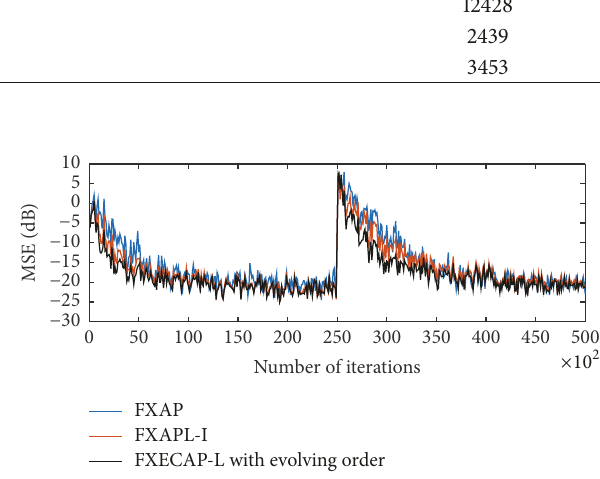
Figure8: MSEvaluesof thetestedAP algorithmsinavariant single- channel system. The projection order used is 𝐿 = 5 and 𝑏 = 2 bits are used to encode the error.